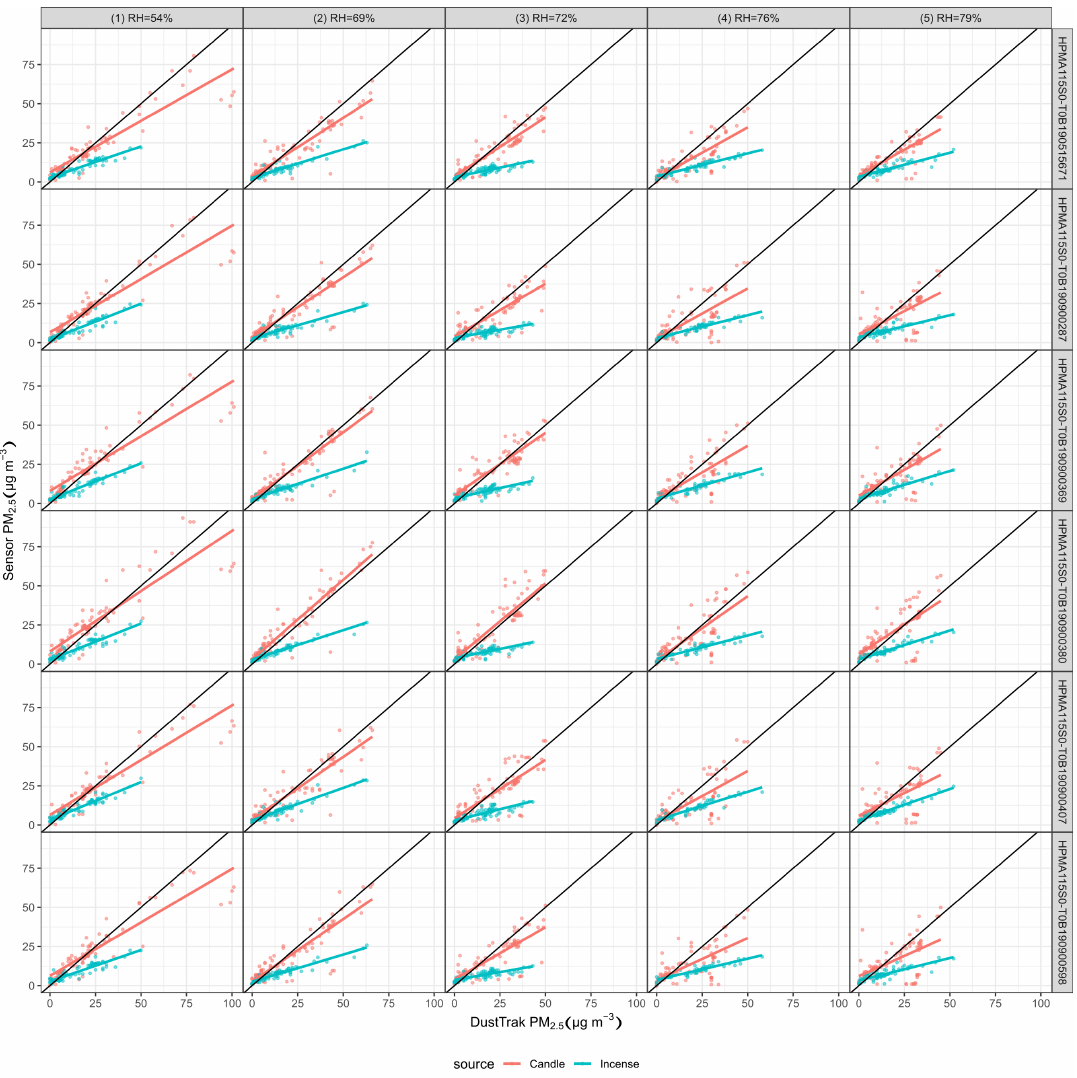
Figure A9. Comparison and linear regression of the Honeywell HPMA115S0 with the DustTrak (x = DustTrak, y = sensors) during the five experiments for peaks and stable concentrations of PM generated using incense and candle. The black line is x =